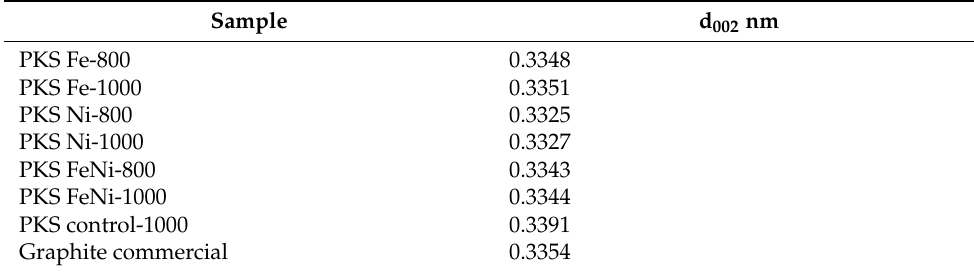
Table 1. d-spacing data of all graphitic carbon